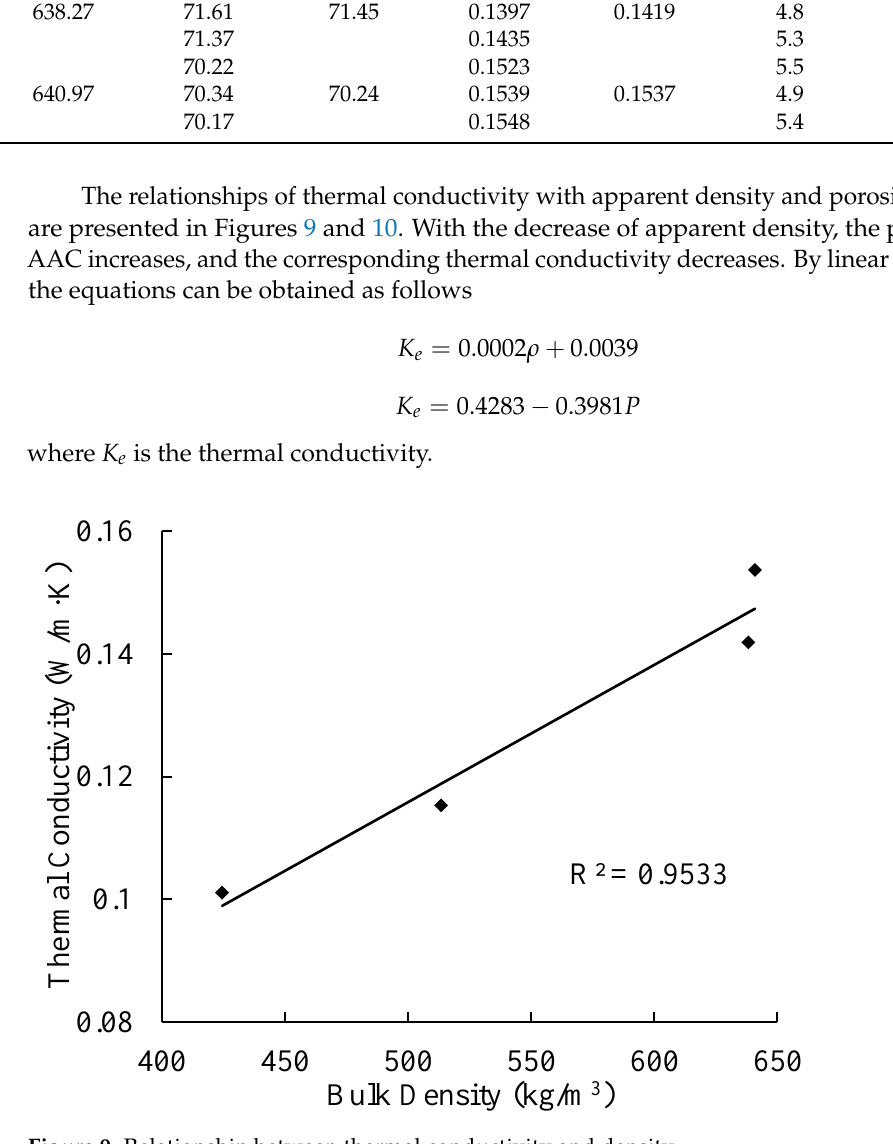
Figure 9. Relationship between thermal conductivity and density.